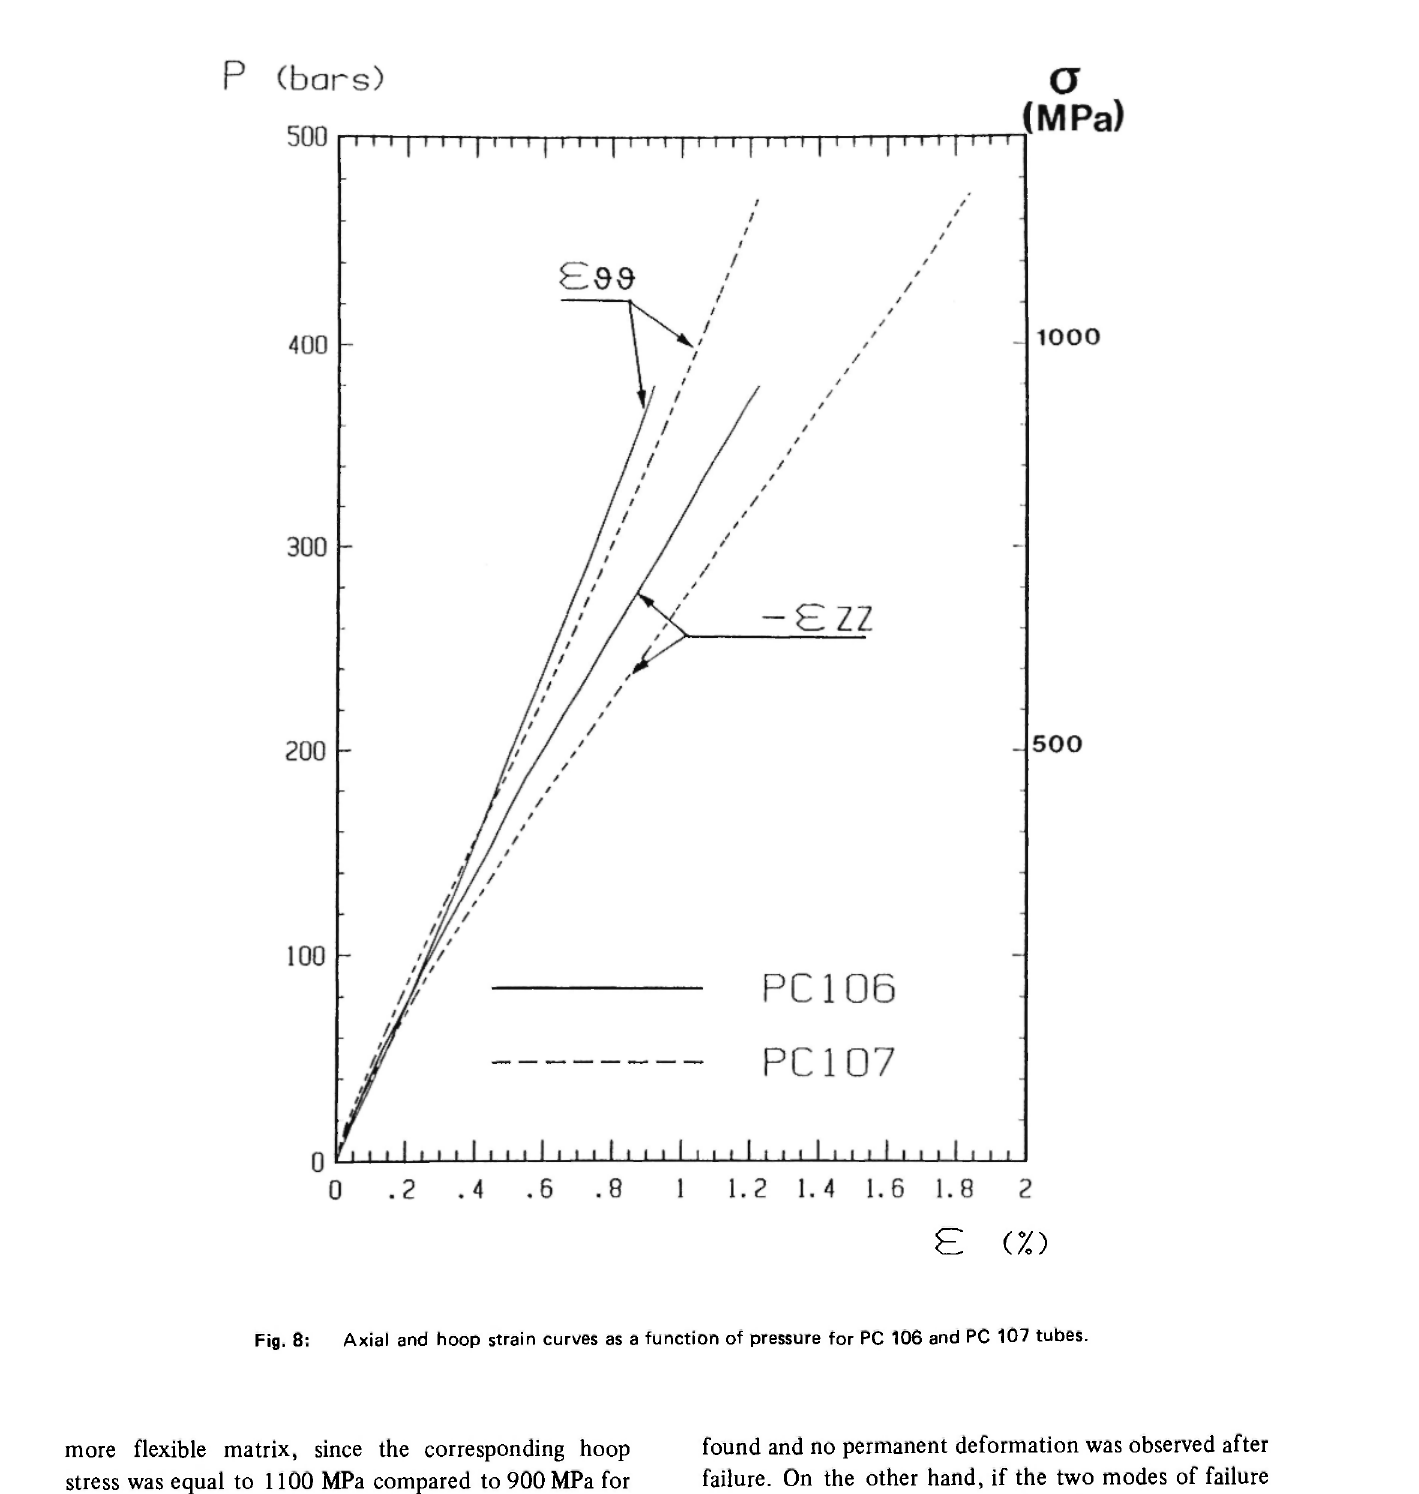
Fig. 8: Axial and hoop strain curves as a function of pressure for PC 106 and PC 107